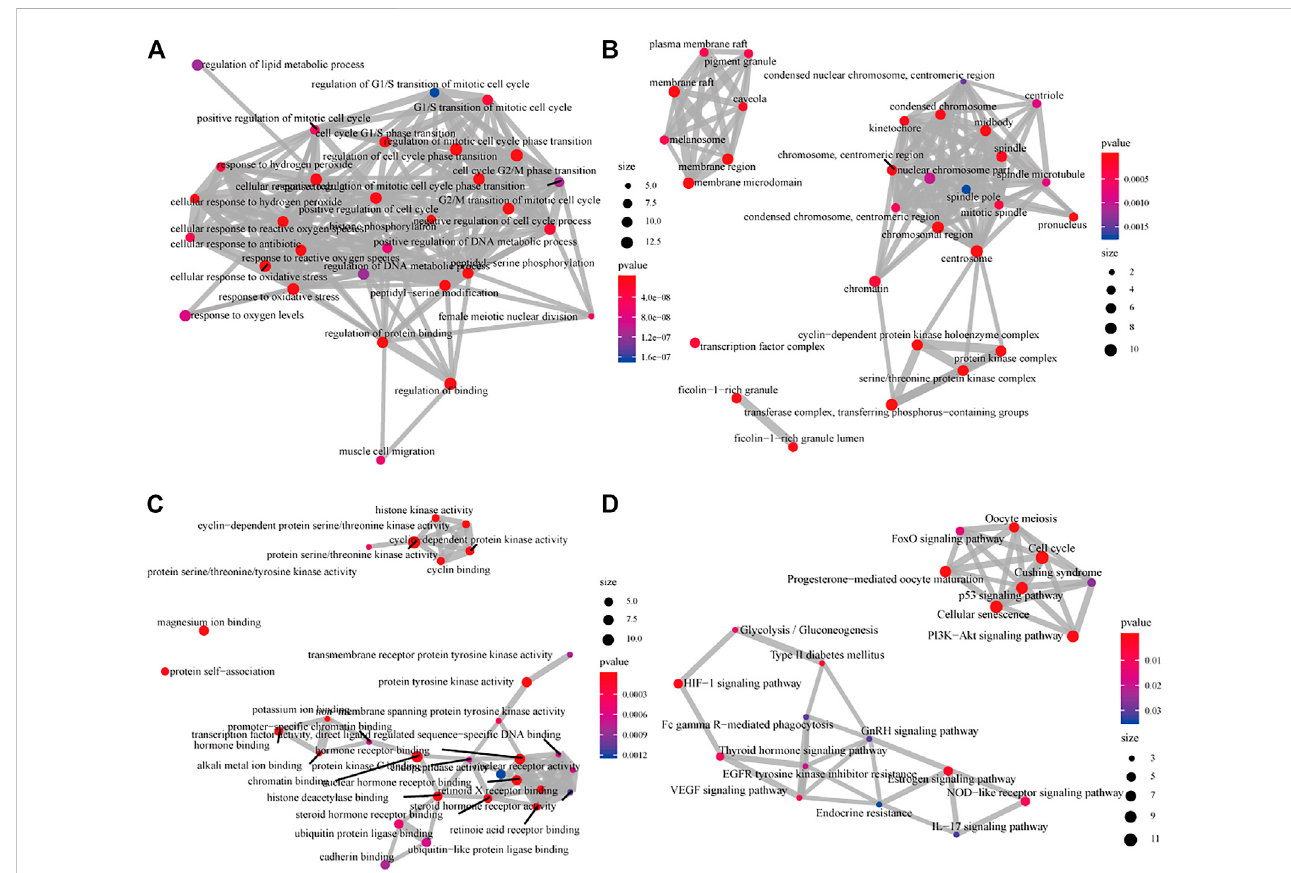
FIGURE 3 GO and KEGG analysis diagram of the intersection of targets of GJF in HCC (A) The analysis diagrams of the biological process (B) Diagrams of the analysis of cell components (C) The analysis diagrams of molecular functions (D) KEGG analysis diagram (GO, gene ontology; KEGG, Kyoto Encyclopedia of Genes and